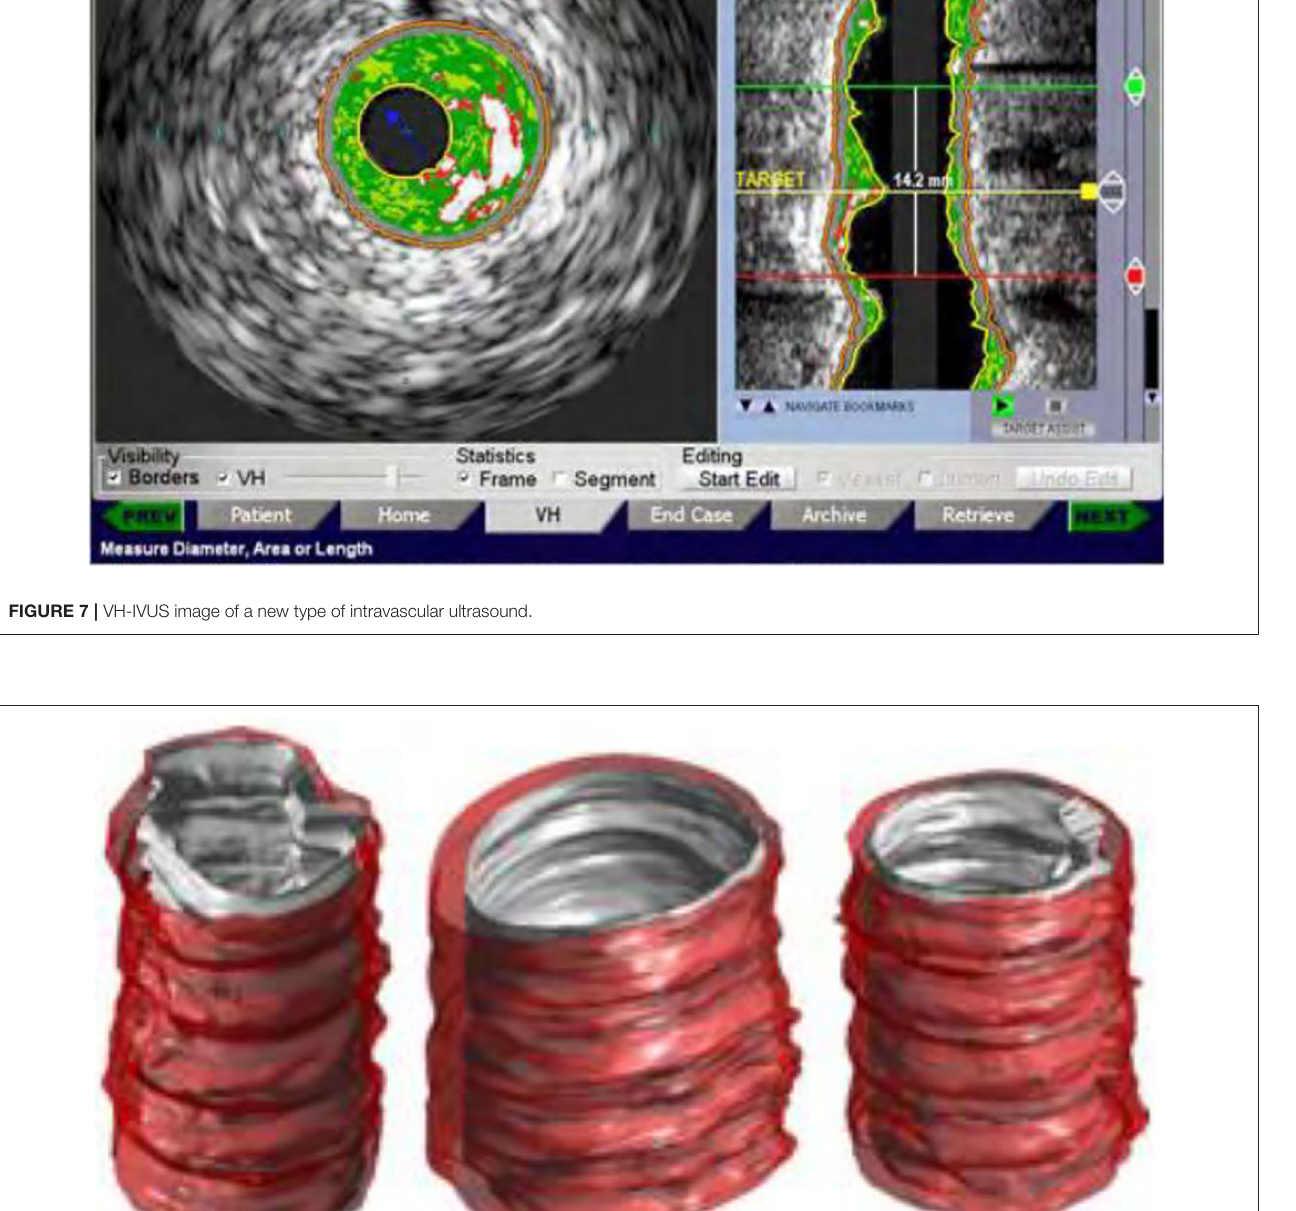
Frontiers in Surgery |